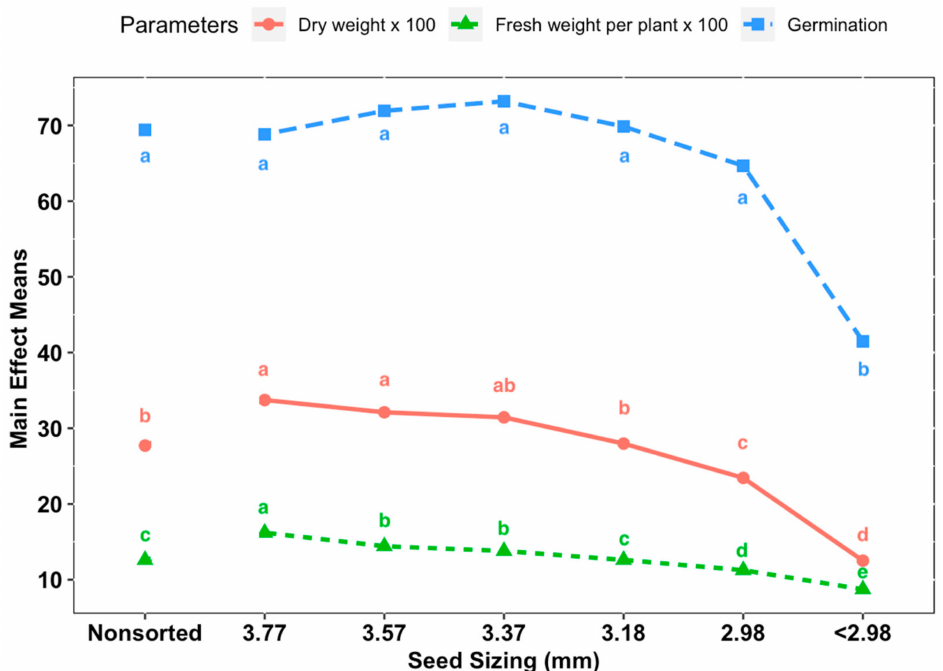
Figure 6. Main e ff ect means of growth parameters for ‘Anka’, ‘Ferimon’ and ‘Picolo’ in response to seed size treatment. Data represent mean of 15 experimental units (3 crop cycles each with 5 experimental units per treatment). Letters represent mean separation comparison using Tukey’s HSD (alpha = 0.05).